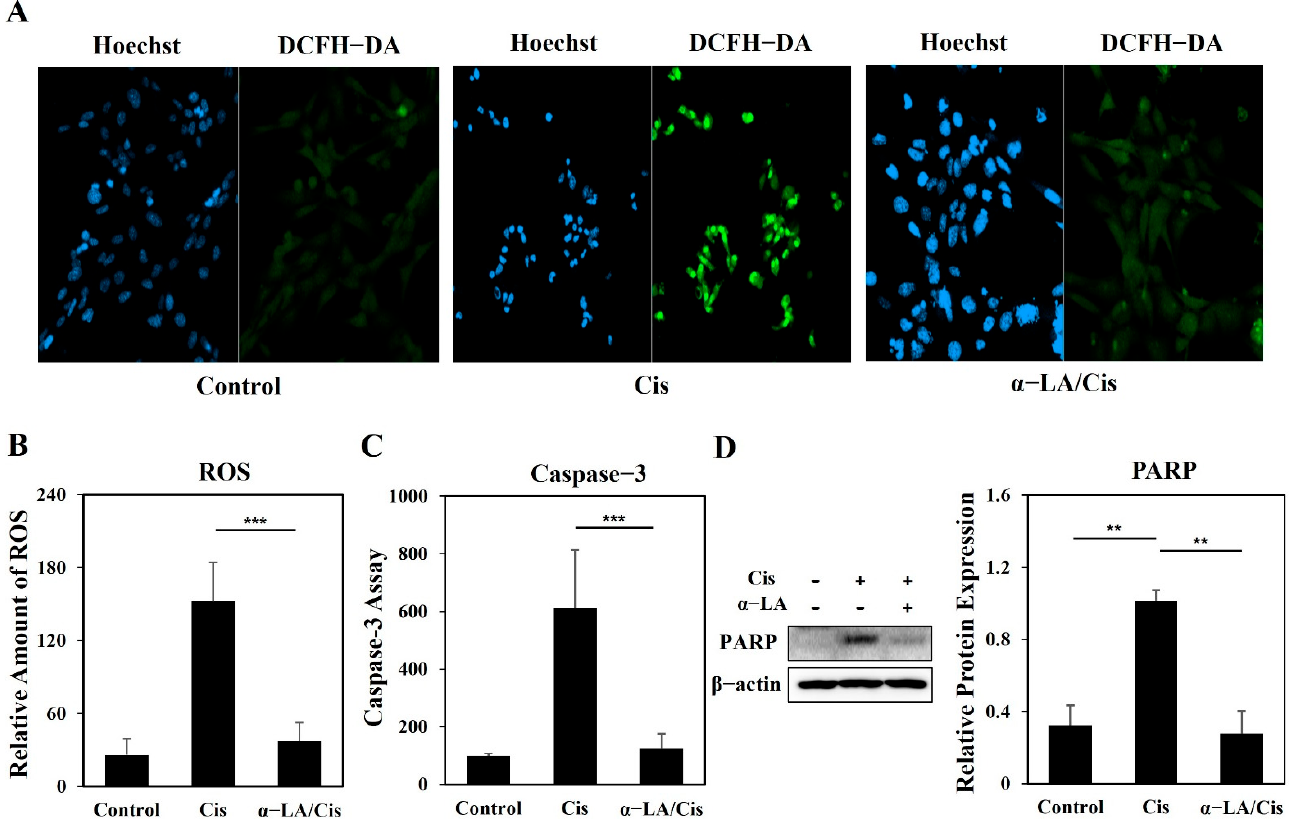
cells are marked with black dotted lines. The region of LDs under the LDs stain in ( E ) is marked in green, and the RI is marked in red. ( H – J ) LDs numbers, masses, and volumes, respectively, meas- ured through RI analysis of 3D images showed high levels in the cisplatin group, while the levels are recovered in the α -LA/Cis group. In 20 independent experiments, 600 cells from each group were compared, and the results are presented as the means ± SDs (** p < 0.01, and *** p < 0.001, determined using one-way ANOVA).